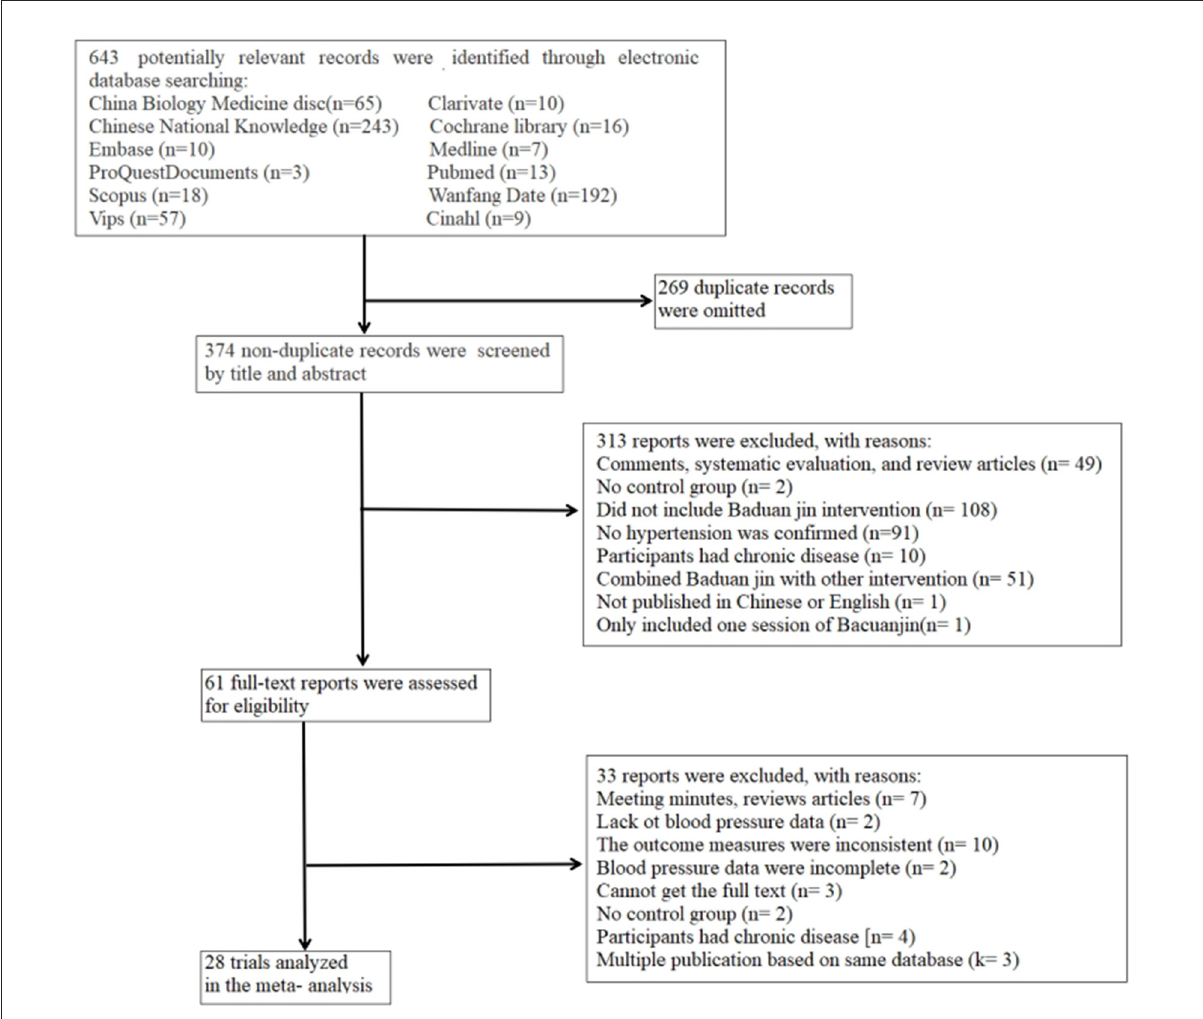
FIGURE1 Flow chart detailing the systematic search of potential reports and selection process of included Baduanjin